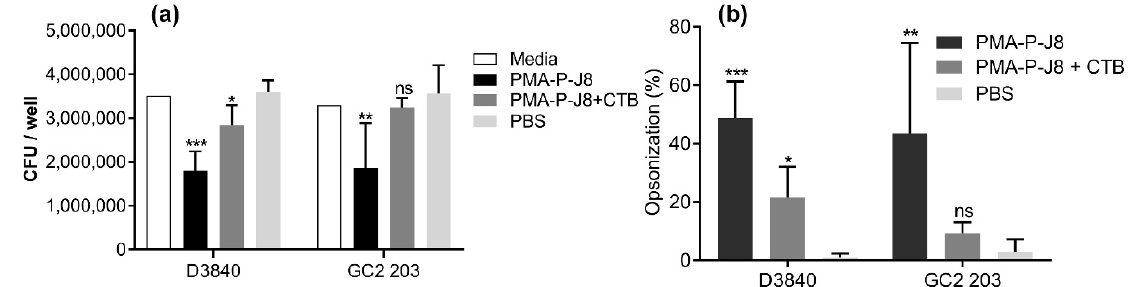
Figure 4. Average opsonization of D3840 and GC2 203 strains by serum collected after two immunizations with PMA-P-J8, PMA-P-J8 + CTB (cholera toxin B), or PBS expressed in ( a ) CFU and ( b ) percentages. Statistical analyses were performed using unpaired t -test in comparison to PBS group. Not significant (ns) p > 0.05, (*) p < 0.05, (**) p < 0.01, (***) p < 0.001.